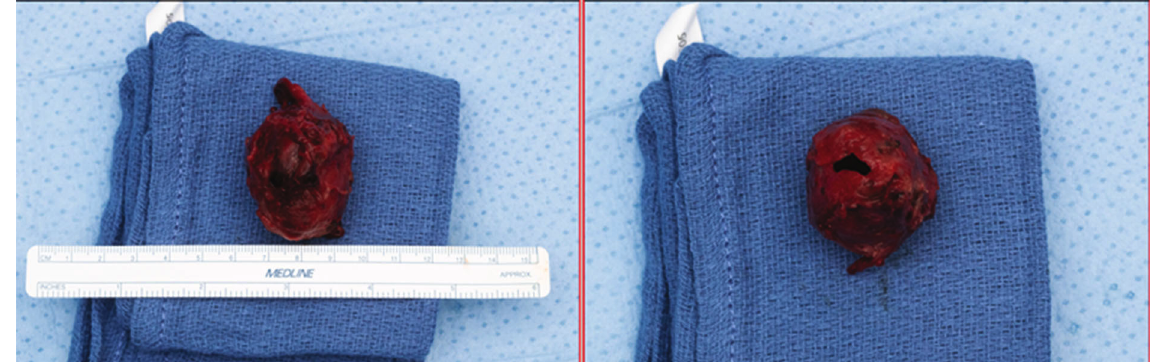
Figure 8: A bone fragment found in close proximity to the